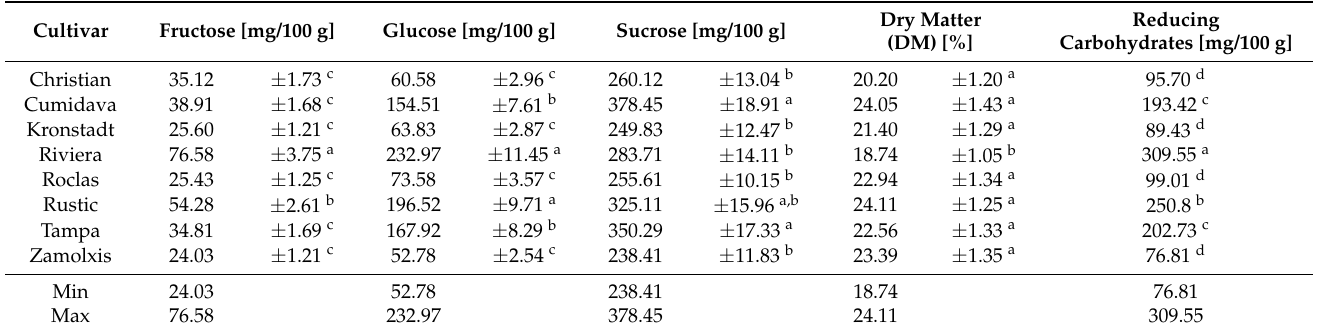
Table 1. SCC in potato cultivars at harvest (mean values of three replicates ± standard deviation; means followed by different superscript letters within the same column indicate significant differences, established using one-way ANOVA with post-hoc Tukey ’s HSD test ( p < 0.05)).